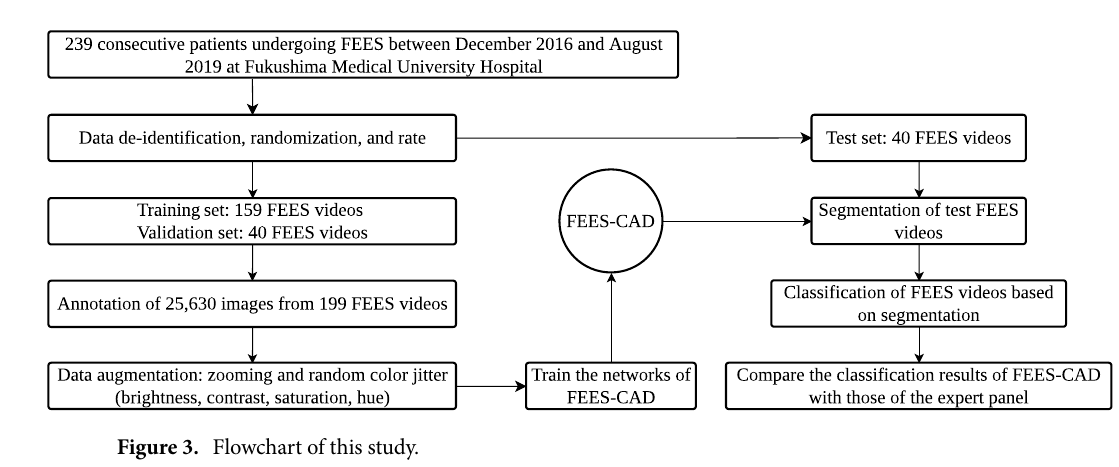
Figure 3. Flowchart of this